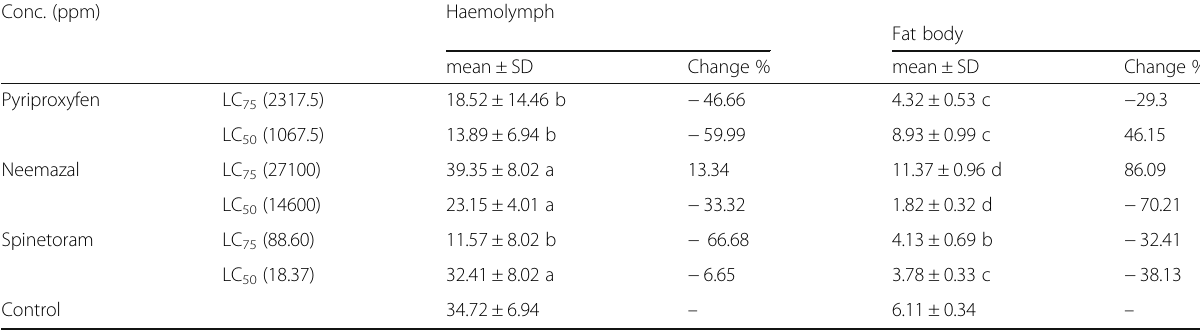
Table 2 ALP activity (U/L) in haemolymph and fat body of the early 5th instar larvae of Rh . ferrugineus after 24-h treatment with LC 50 and LC 75 of the tested insecticidal compounds Conc. (ppm)